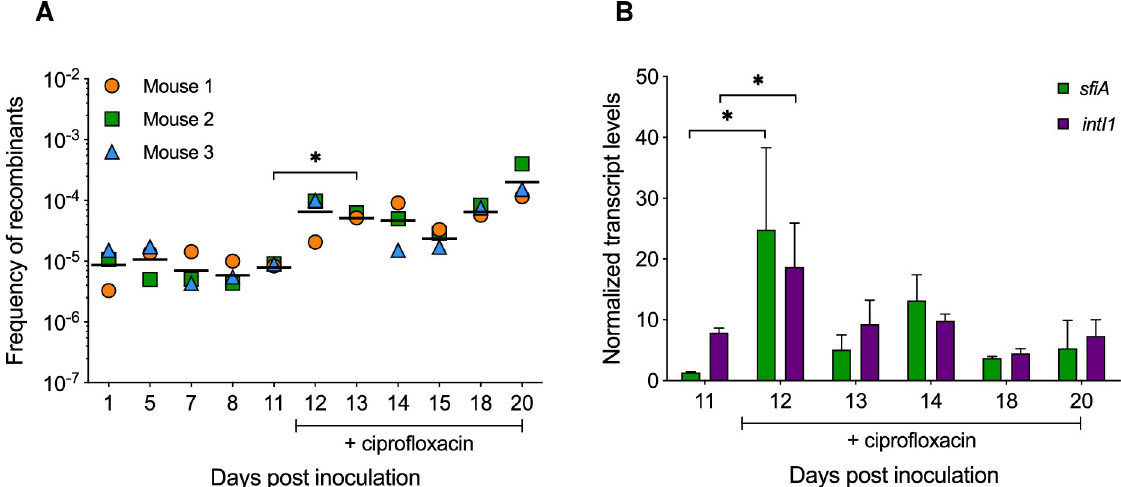
Fig 4. Effect of ciprofloxacin on the induction of the SOS response and the IntI1 integrase expression and activity in the mouse gut. On day 0, three germ-free mice were inoculated with 10 8 CFU of MG/intI1 (carrying p6851 and pZE1intI1 allowing the expression of intI1 SOS- regulated). Ciprofloxacin was added to the drinking water of mice on day 11 post inoculation, just after the fecal sampling on that day. (A) Recombination activity of IntI1, reflected by the frequency of recombinants (FR), was estimated by determining the frequency of emergence of tobramycin-resistant recombinants, as a result of specific recombination between attC sites located on a synthetic array of two cassettes � ) carried on plasmid p6851. Each symbol represents the FR in the gut calculated from a single mouse ( attC - cat(T4) - attC aadA7 VCR2 -aac(6’)-Ib exhibiting recombinants. For each sampling day, the average FR is shown as a black horizontal line. (B) Transcript levels of sfiA and intI1 genes in the mouse gut are represented. Transcript levels were normalized to the housekeeping gene dxs . Error bars indicate the SD. Differences were determined using the Mann-Whitney U test. � p < 0.05.